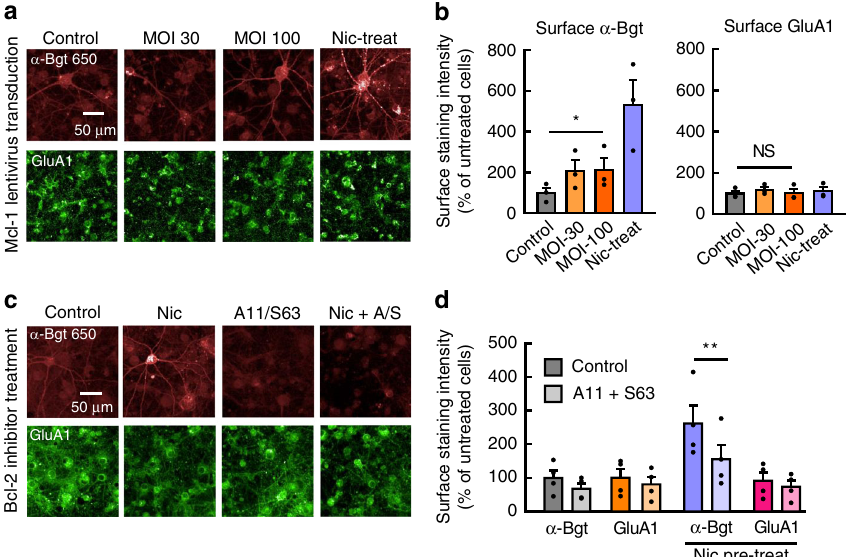
Fig. 5 Bcl-2 proteins regulate α 7 nAChRs in hippocampal neurons. a Fluorescent labeling of nonpermeabilized rat hippocampal neurons (DIV 20) transduced with lentivirus encoding human Mcl-1 at DIV7 or incubated with 100 µ M nicotine (Nic) since DIV 15. Representative images of surface α -Bgt and surface GluA1 (AMPA receptor) labeling of neurons are shown. b Quanti fi cation of surface α -Bgt (left) and surface GluA1 (right) labeling, expressed as a percentage of the intensity from untreated neurons. Two multiplicities of infection (MOI 30 and 100) were compared to ensure maximal lentiviral transduction occurred. Data are averaged from three experiments on different cultures (* p < 0.05). At MOI 100, there was a signi fi cant increase in α -Bgt staining, but not GluA1 staining ( p = 0.41, paired one-tail t test). c Fluorescent labeling of nonpermeabilized rat hippocampal neurons (DIV 21) treated for 96 h with the Bcl-X L inhibitor A-1155463 (A11, 10 nM) and Mcl-1 inhibitor S-63845 (S63, 10 nM), with or without coincubation in 100 µ M nicotine (Nic) to promote α 7 nAChR surface expression. Representative images of surface α -Bgt and surface GluA1 labeling are shown. d Quanti fi cation of surface α -Bgt and surface GluA1 fl uorescence labeling intensity, expressed as a percentage of the fl uorescence from untreated neurons. Data are averaged from four experiments on different cultures (** p < 0.01). With nicotine pretreatment, Bcl-2 inhibitors induced a signi fi cant decrease in α -Bgt staining, but not GluA1 staining ( p = 0.09, paired one-tail t test). All data are means ±